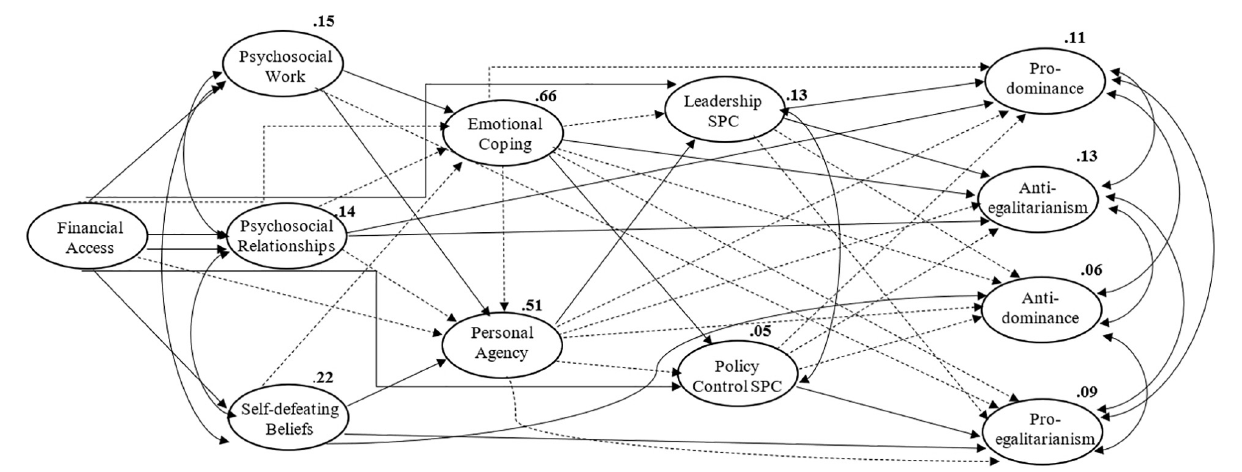
FIGURE 3 | Model B, representing all paths